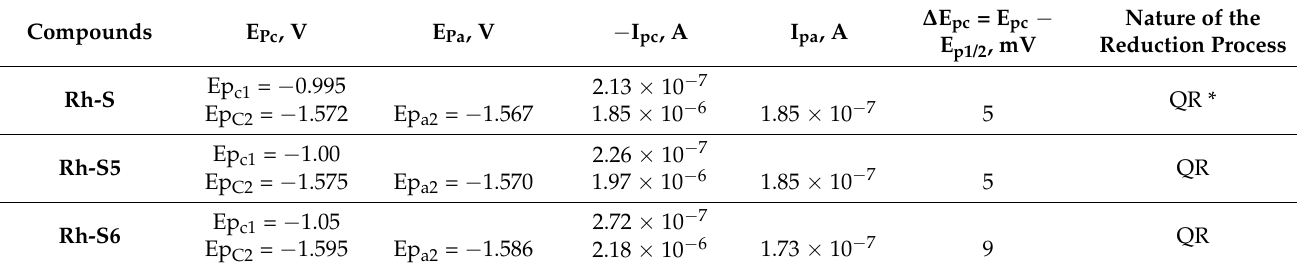
Table 3. Voltamperometric characteristic of investigated peptides: Rh-S (1.36 × 10 − 5 mol L − 1 ), Rh-S5